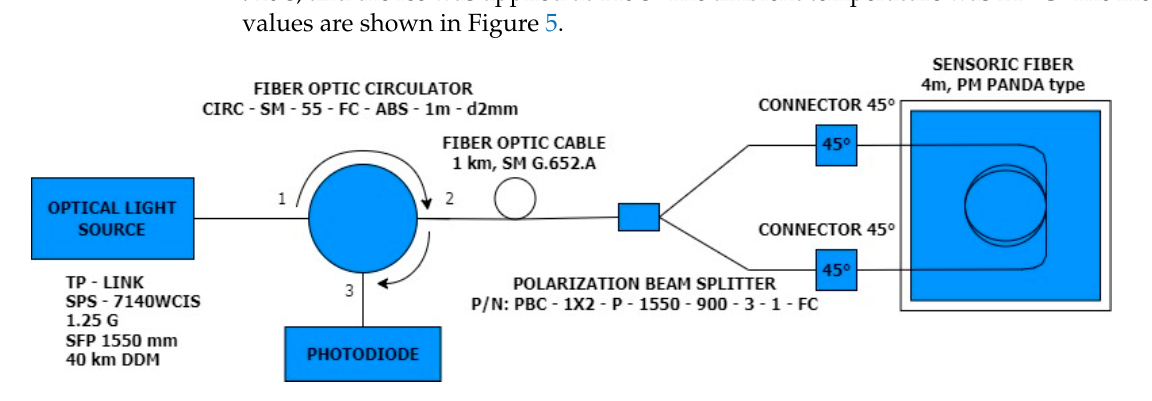
Figure 4. Wiring diagram with the circulator and two-way sensor (measurement no. 0379).